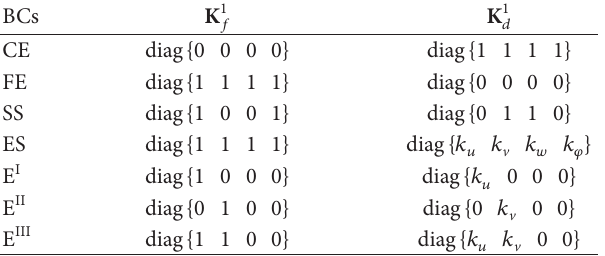
Table 1: Coefficient matrices for common boundary